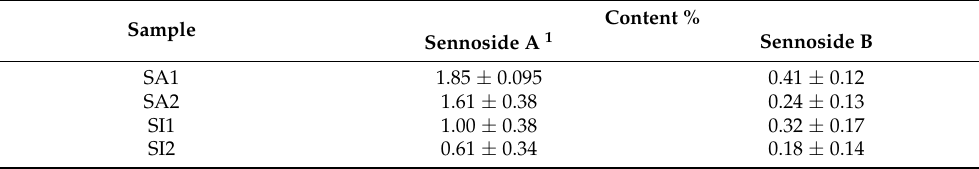
Table 2. The amounts of sennosides A and B in 70% and 100% MeOH extracts of S. italica and S. alexandrina . SA1, SA2, SI1, and SI2 refer to S. alexandrina 100%, S. alexandrina 70%, S. italica 100%, and S. italica 70% MeOH extracts,